Question: Which kind of chart has been used to present this data?
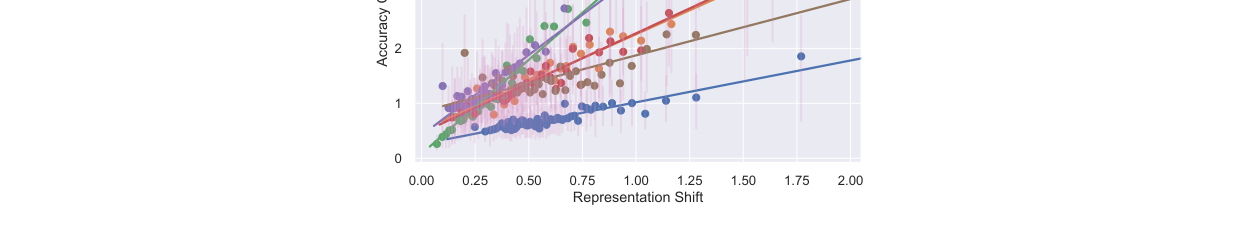
Answer: scatter